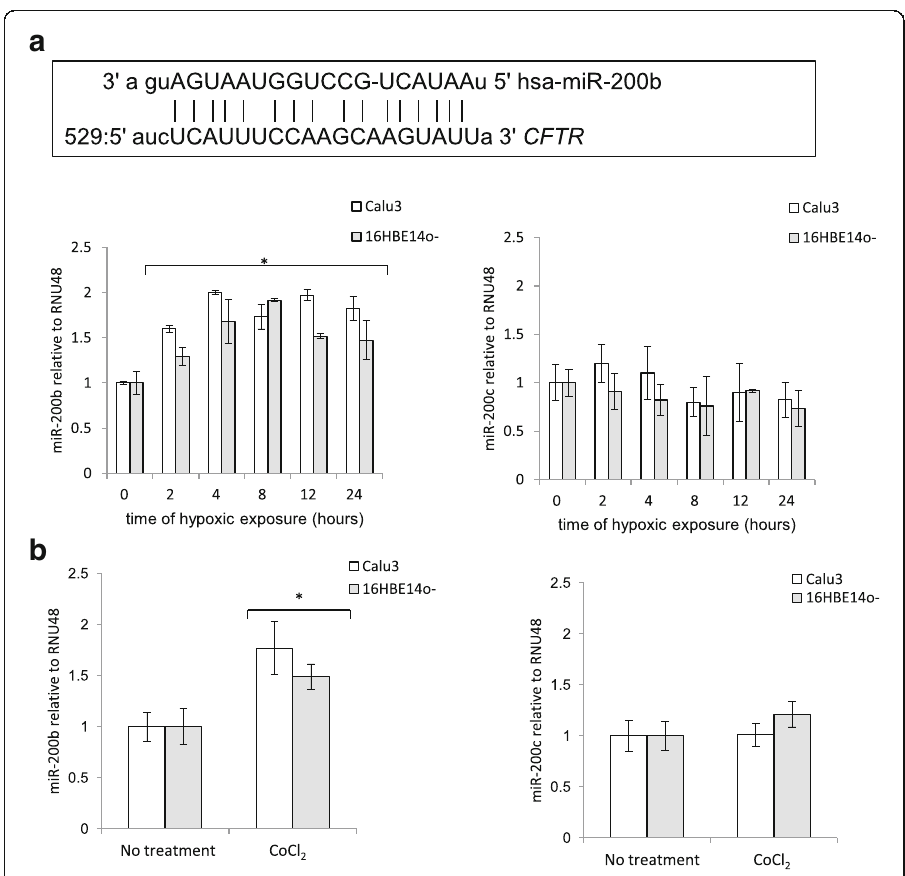
Fig. 3 Hypoxia induces miR-200b in human airway epithelial cells in a HIF-1-dependent manner. a The predicted target site of miR-200b in CFTR 3 ′ UTR is shown above. The miR-200b target site was predicted in human CFTR 3 ′ UTR only, Hypoxia-induced changes in the expression profiles of miR-200b and miR-200c in Calu3 and 16HBE14o- cells are shown. The miRNA levels were monitored in qRT-PCR experiments. The results from 2 independent experiments ( n = 8) are plotted normalized to RNU48 and expressed as a fold-change over the normoxic control. b Calu3 and 16HBE14o- cells were treated with hypoxia mimetic (200 μ M CoCl 2 for 12 h) and the miRNA levels were monitored in qRT-PCR experiments. miR-200b and miR-200c levels were measured in 3 independent experiments ( n = 10) and are plotted relative to RNU44 levels and expressed as a fold change over the untreated controls. Error bars represent standard deviations (SD). Significant changes ( P < 0.05) are marked with an